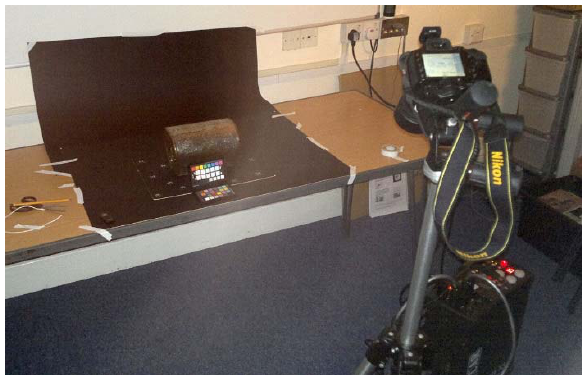
Figure 3. Setup for photography of the handbag, showing cove, colour chart, camera on tripod and flash controller.